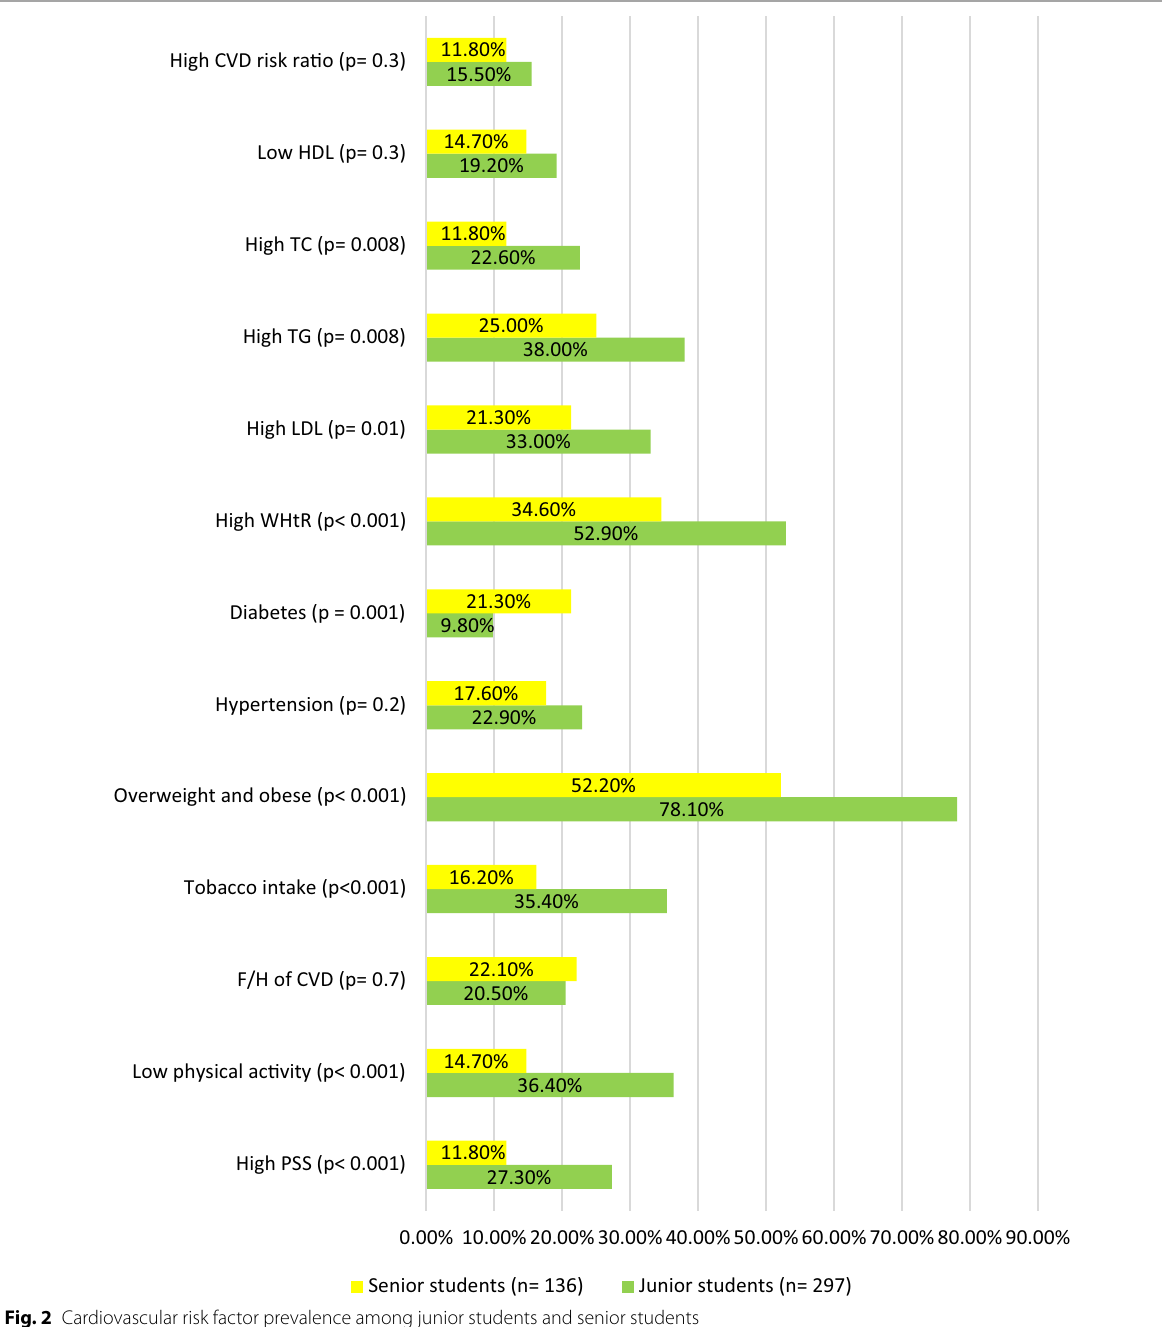
Fig. 3. Additional file 1: Table S3 details the statistics of this analysis.